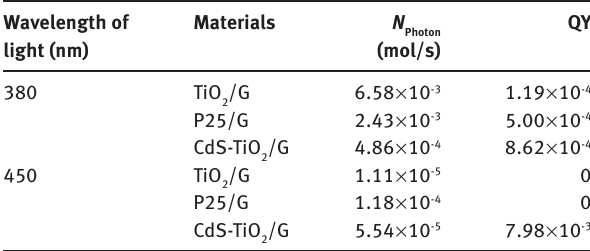
Table 1: The number of photons absorbed, N QY of the prepared photocatalyst materials at 380 and 450 nm of light at 60 min of degradation.